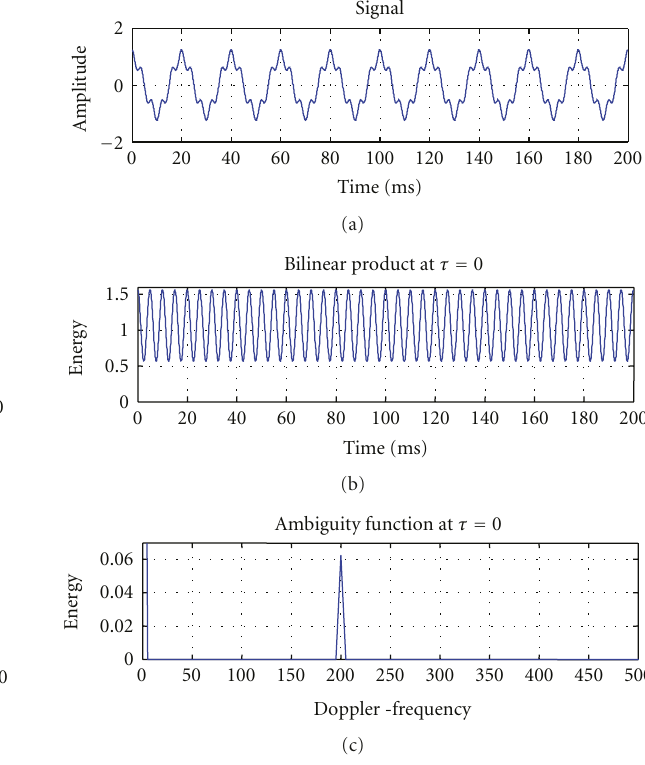
Figure 10: (a) Harmonic signal, (b) its bilinear product, and (c) ambiguity function at τ =